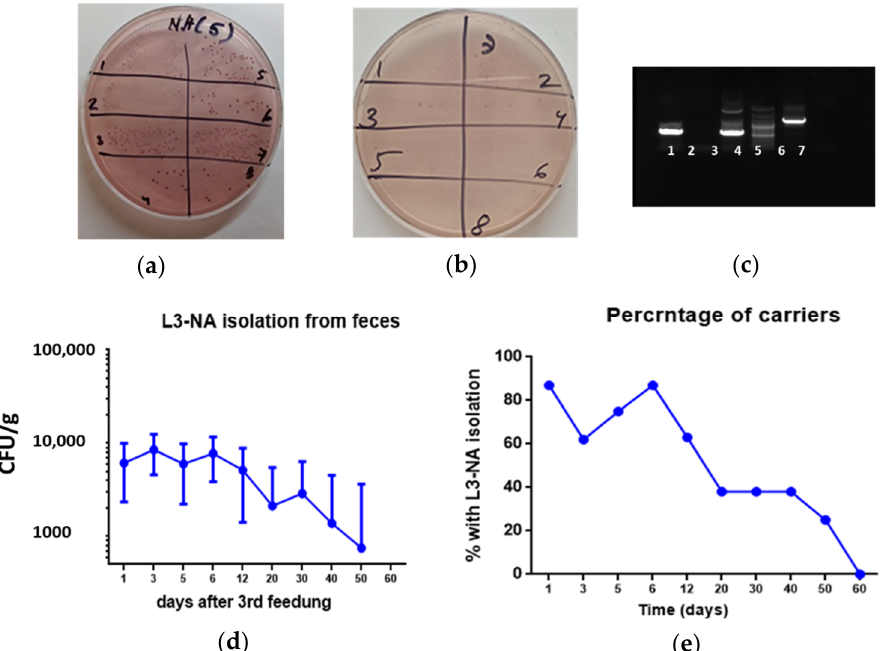
Figure 5. Bacterial persistence in the intestines of L3-NA immunized animals ( n = 8). ( a , b ) Colonies of enterococcus on azide agar on day 5 and 60 after the 3rd immunization respectively; ( c ) NA identification by PCR using EV и FV primers (EV: 1, PCR product using template DNA from L3-NA colony (azide er+ agar); 2, PCR product using template DNA from L3 colony (azide er- agar); 3, PCR product using plasmid pentF-NA-1 template DNA; 4, 100 bp ladder DNA marker (100–3000 bp); 5, PCR product using template DNA from L3-NA colony (azide er+ agar); 6, PCR product using template DNA from L3 colony (azide agar er-) and B1 и FV as primer sequences; 7, PCR product without added DNA; ( d ) L3-NA isolation from stool samples; ( e ) Percent of mice with L3-NA isolation.